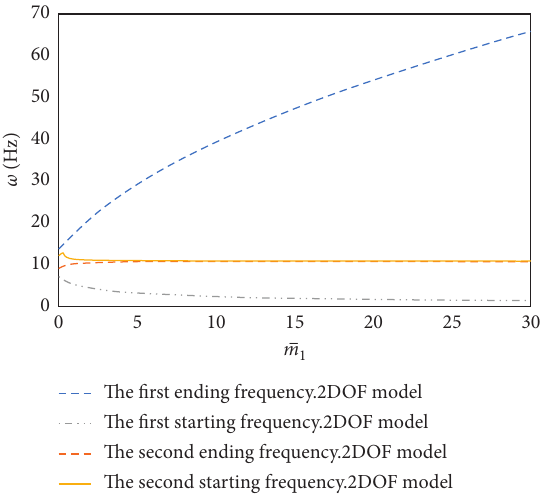
Figure 16: The effect of m model.